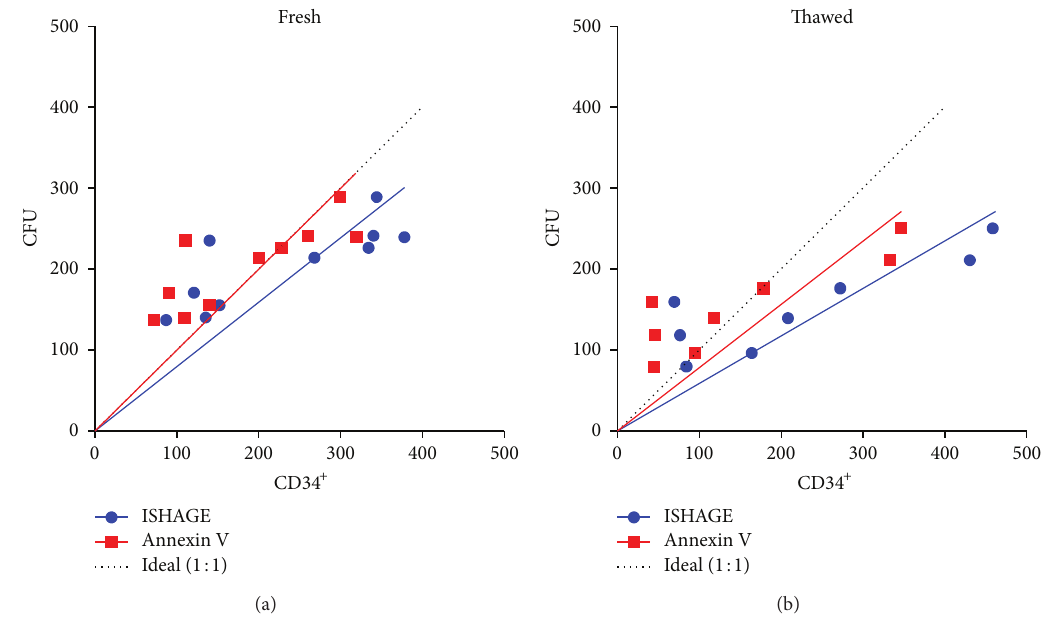
Figure 3: CFU observed versus the amount of CD3 4 + cells seeded assessed by different methods. Following the linear regression, Annexin V-based analysis (red squares) resulted in values closer to the theoretical expected results (dotted line) than those of the standard ISHAGE- protocol (blue circles) either after volume reduction or after thawing.